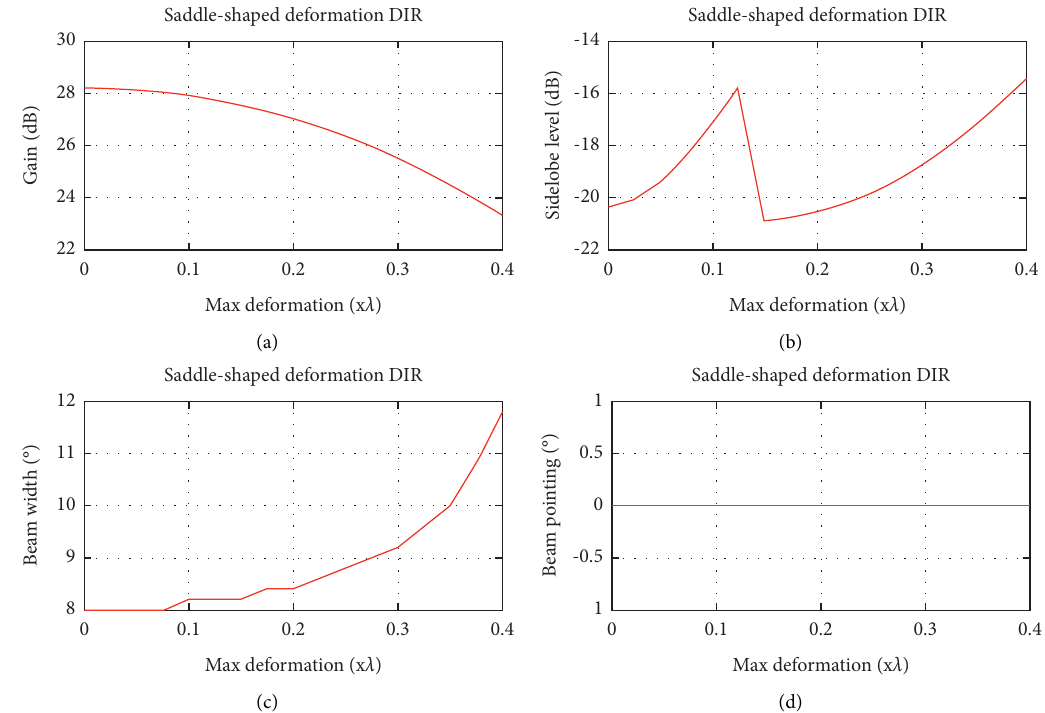
Figure 19: Changes in technical indicators of azimuth plane caused by saddle-shaped deformation. (a) Gain. (b) Sidelobe level. (c) Beam width. (d) Beam pointing.